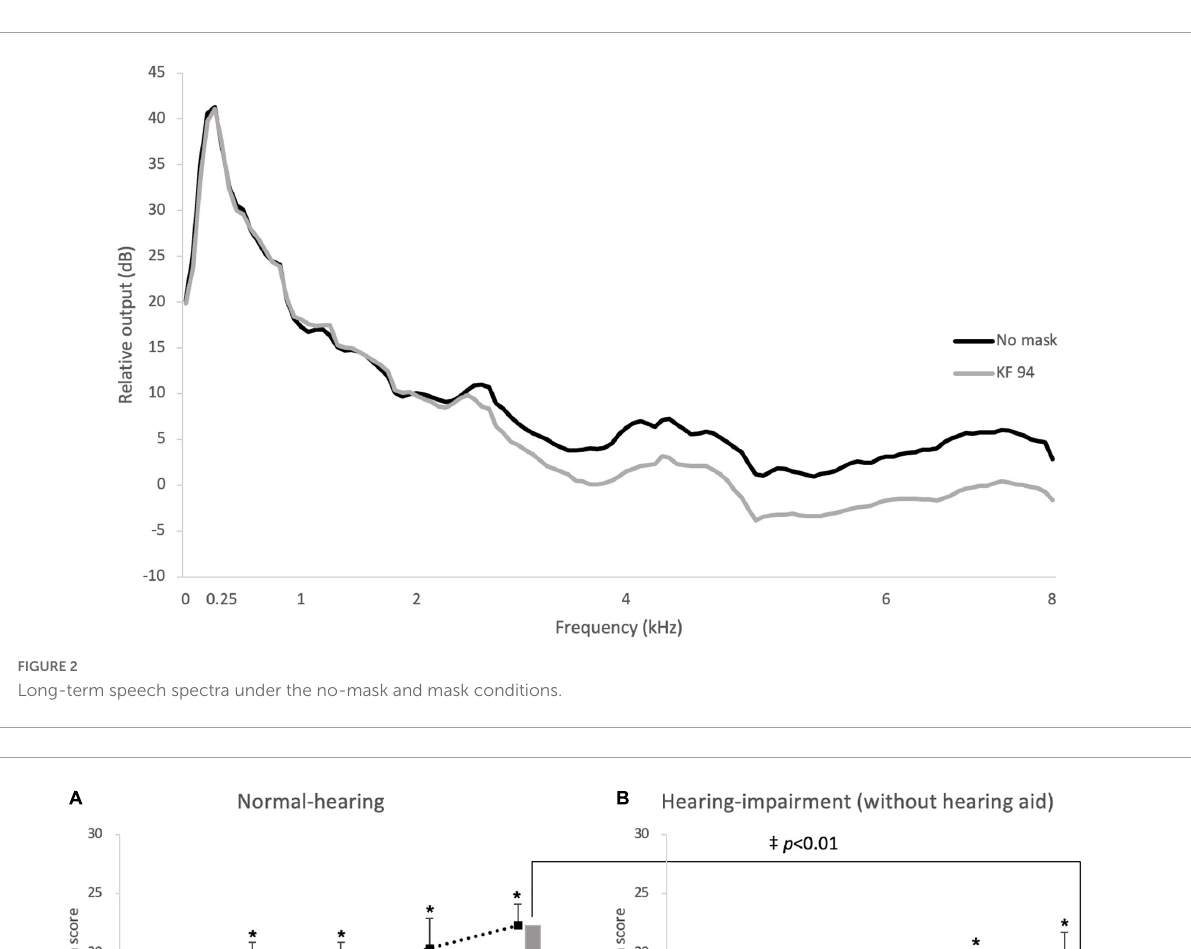
FIGURE2 Long-term speech spectra under the no-mask and mask conditions.